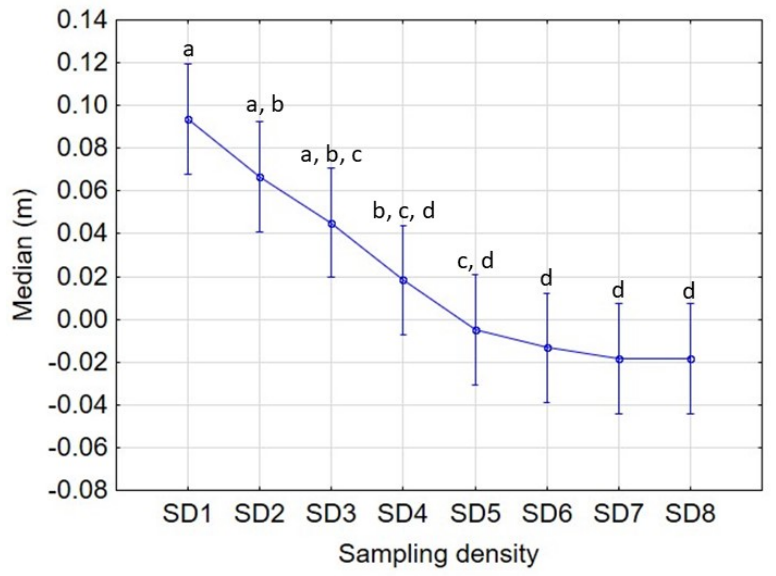
Figure 8. Trend graph of the median of the residuals (Z interpolated − Z checkpoint ) with respect to the factor Sampling Density. For each SD all morphologies and interpolation methods are included. Vertical bars denote 95% confidence intervals. Different letters between sampling densities indicate significant differences according to Tukey’s test ( p < 0.05).